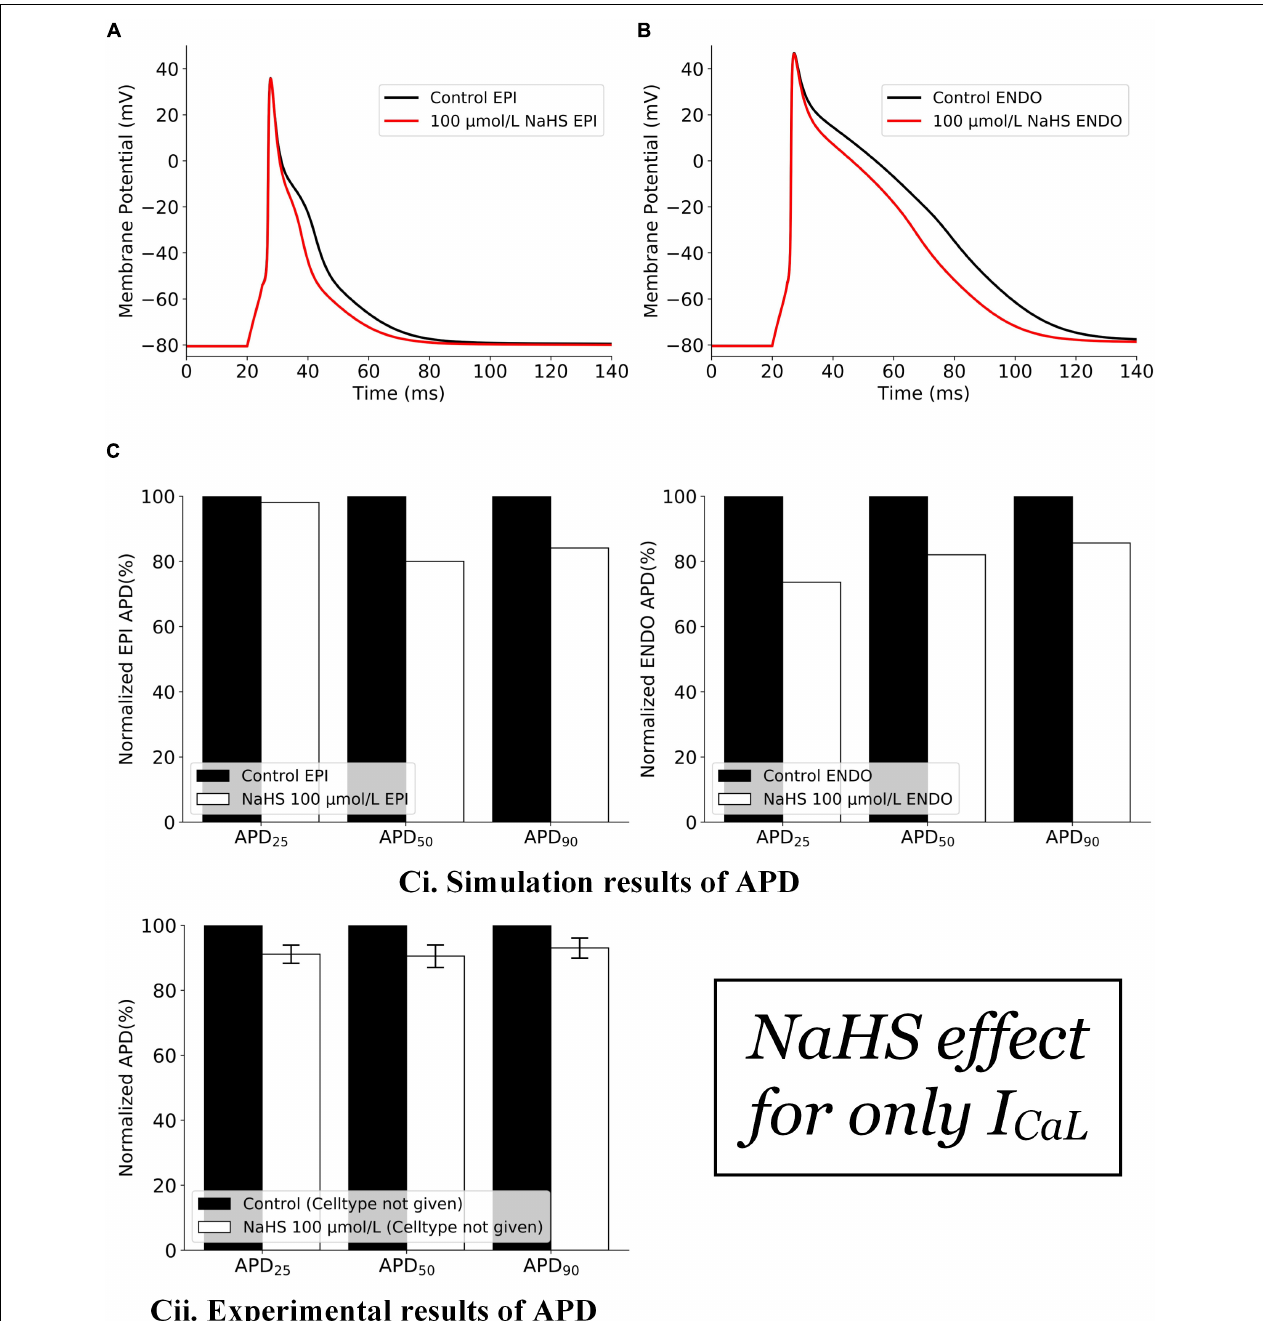
FIGURE 1 | Effects of 100 µ mol/L NaHS on AP by its inhibition action on Ca-L channels alone. (A) APs of epicardial myocytes in control and NaHS conditions. (B) APs of endocardial myocytes in control and NaHS conditions. (C) Comparison of APD abbreviation between simulation and experimental data. (i) Simulation results; (ii) experimental results from Sun et al. (2008) without specifying cell types. AP, action potential; APD, action potential